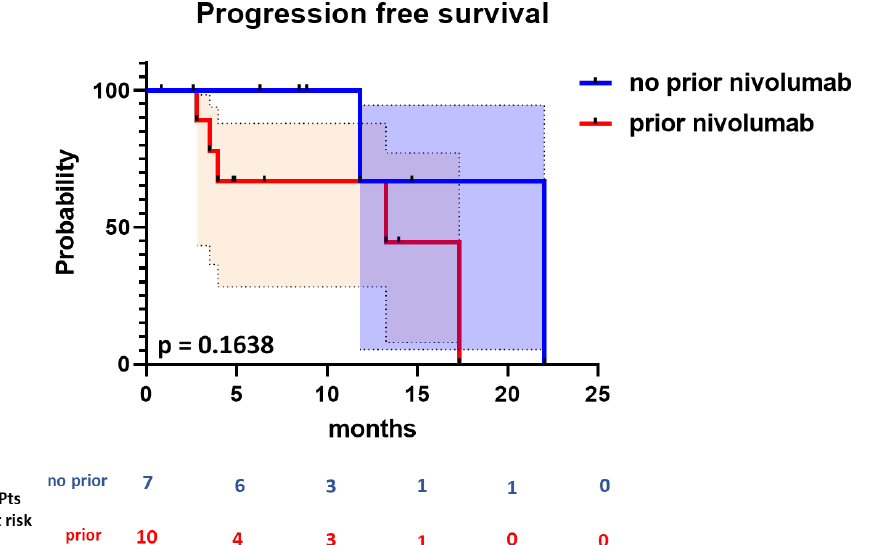
Figure 2. Progression-free survival stratified into nivolumab naïve patients (blue line) and patients with prior nivolumab (red line).